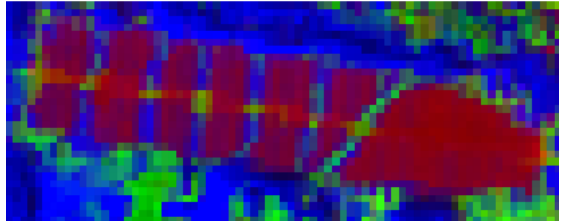
Figure 9: DESIS unmixing results. The PV abundance map is reported in red, while aggregates of other materials appear in blue and green.